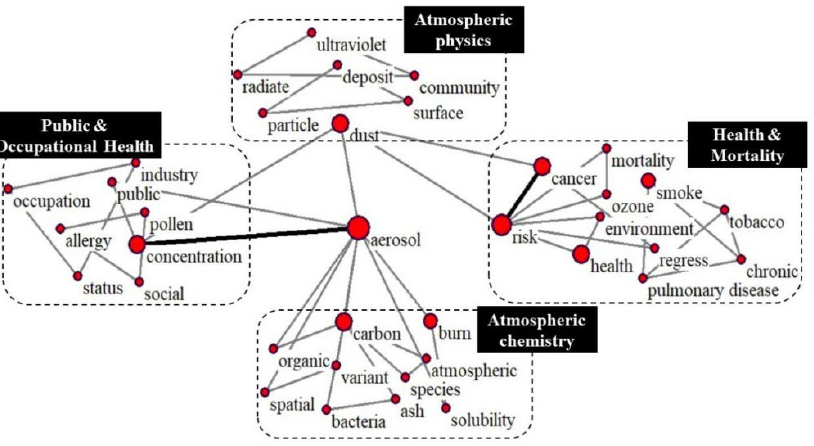
Figure 9. Group III research topics .